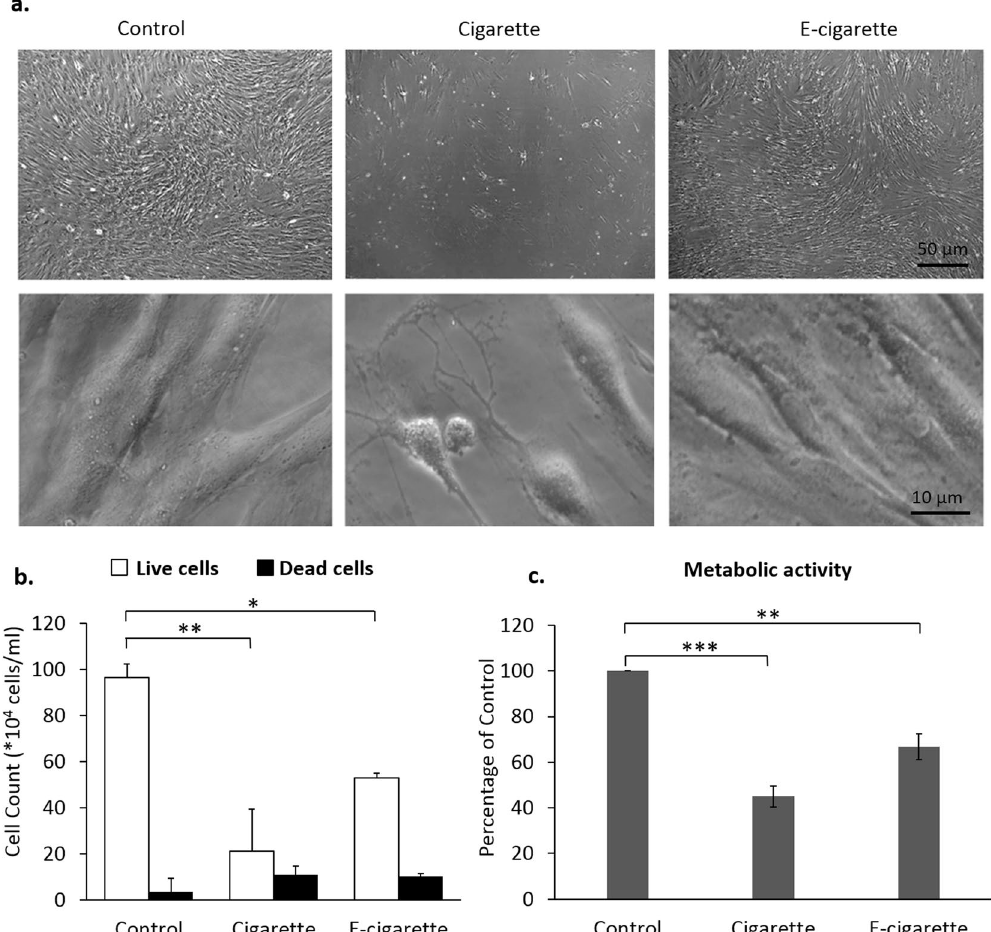
Figure 1. Cigarette and e-cigarette smoke extracts alter MSC morphology and growth. MSCs were repeatedly (once every 3 days) exposed to cigarette and e-cigarette smoke extracts for 21 days. ( a ) MSC morphology was examined by light microscopy (upper panel). High magnification DIC images are shown in the lower panel. ( b ) On day 21, cell viability was assessed using the trypan blue dye exclusion assay. Histograms display averages ± SD of 3 independent experiments in duplicates. ( c ) On day 21, the metabolic activity of MSCs was assessed by MTT. Histograms display averages ± SD of 2 independent experiments in triplicates. * p < 0.01, ** p < 0.005 and *** p <